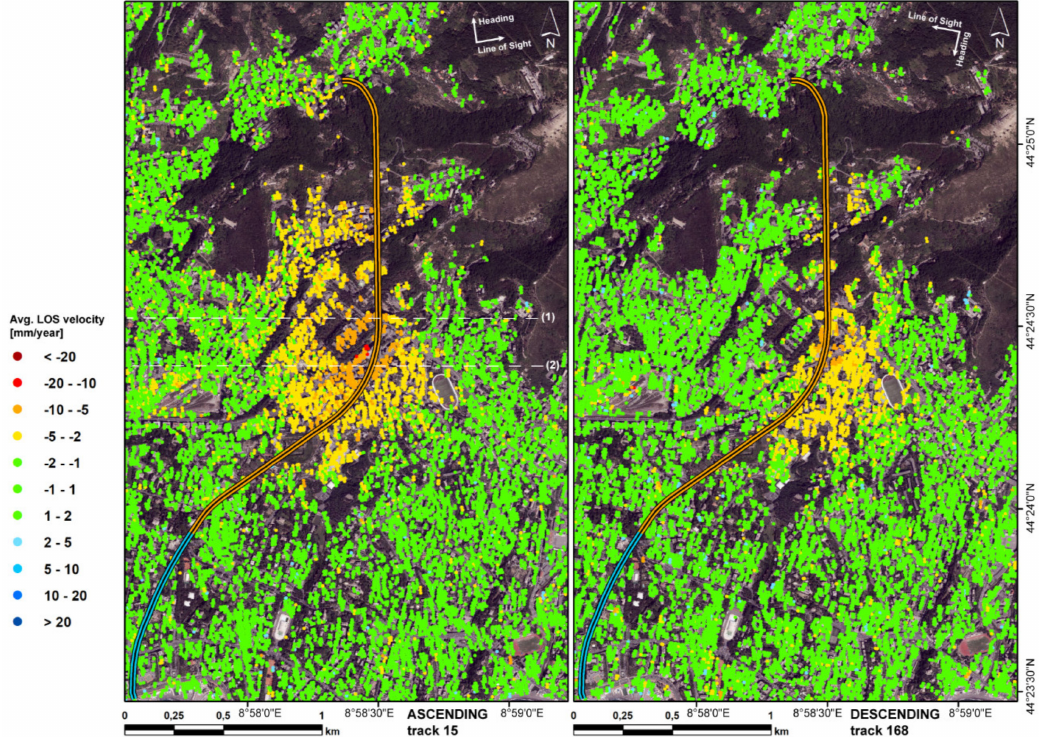
Figure 5. Close-up of the average displacement rates (LOS direction, mm/y) above the Fereggiano tunnel from Sentinel-1 SAR data 2015-2018. Negative values (from yellow to red) indicates a lowering of the surface. Crosssections (1) and (2) are represented in the Figure